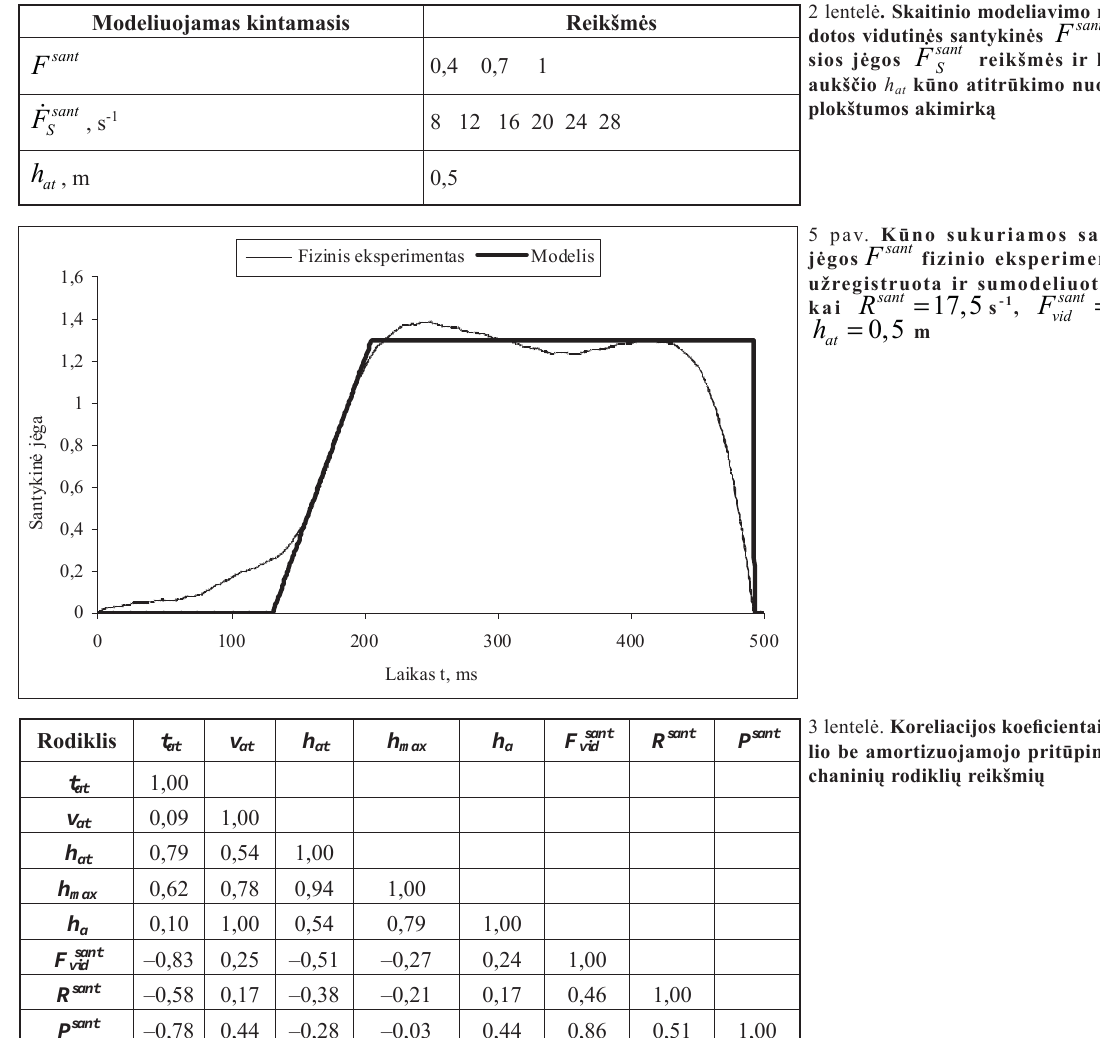
(t. y. kol k ū no MC pasiekia h = 0,5 m aukšt į ). Pa- at vyzdžiui, 5 paveiksle parodyta fi zinio eksperimento metu užregistruota ir sumodeliuota santykin ė s j ė gos